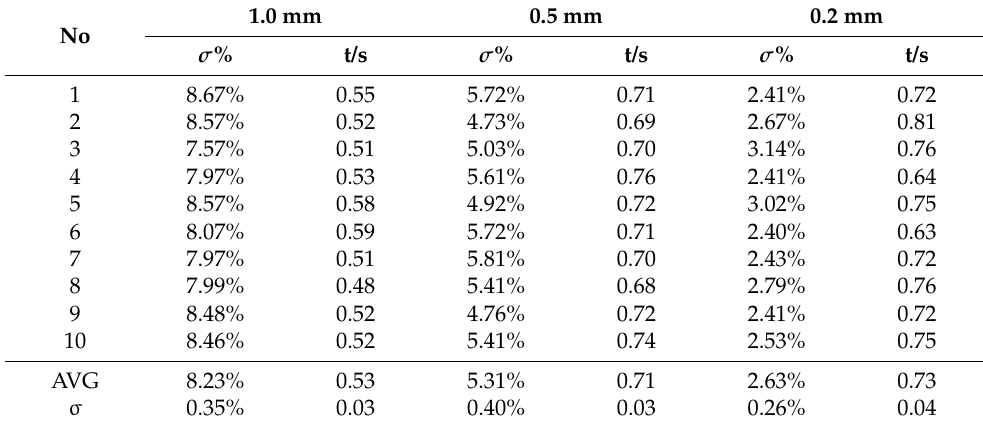
Table 2. Comparison of the dynamic characteristics of the repeatability test of descending motion.